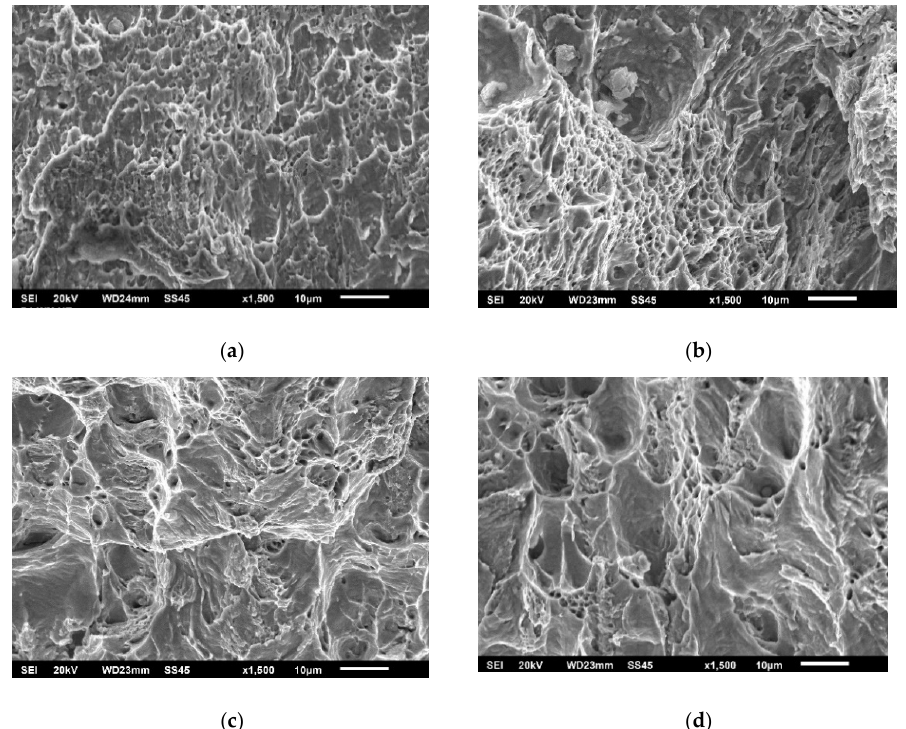
Figure 9. SA ‐ 387 Gr. 91 WM fractography upon ( a ) crack initiation, 575 ° C; ( b ) crack propagation, 575 ° C; ( c ) crack initiation, 20 ° C; and ( d ) crack propagation, 20 ° C.